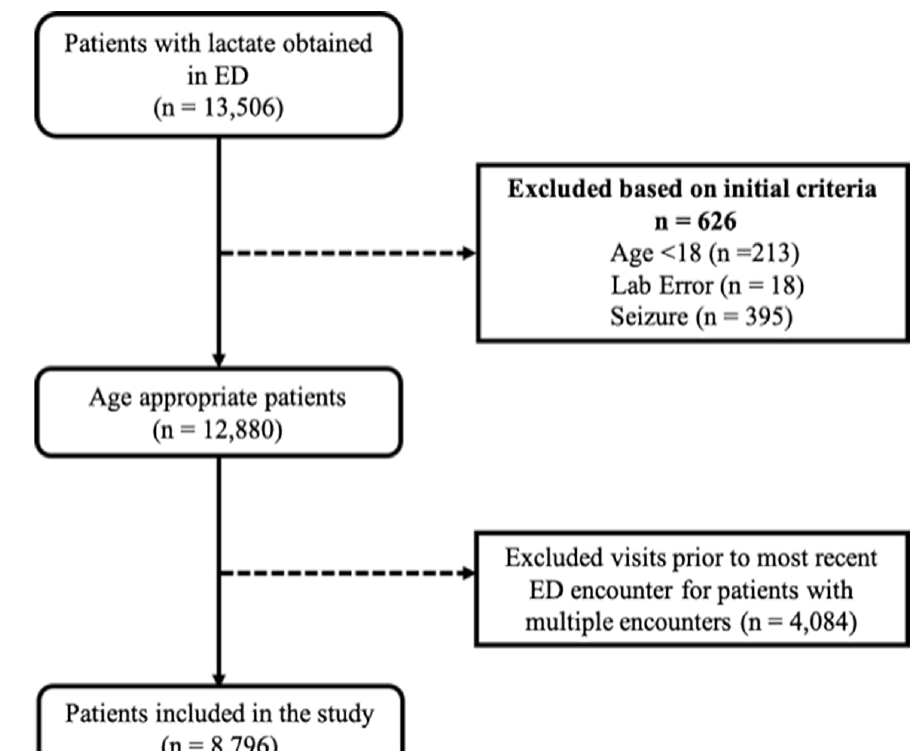
Figure 1. Study flowchart depicting the inclusion and exclusion criteria for ED patients with lactate levels. ED, emergency